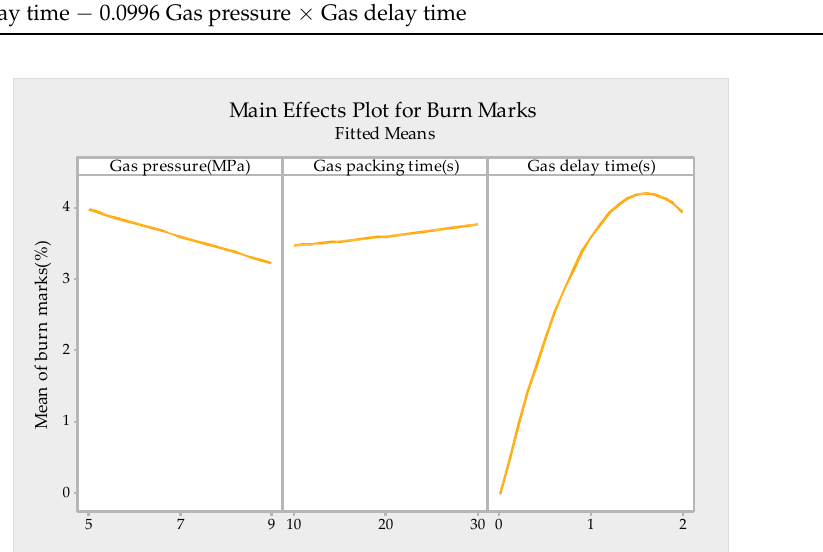
Figure 8. Main effects plot for burn marks.